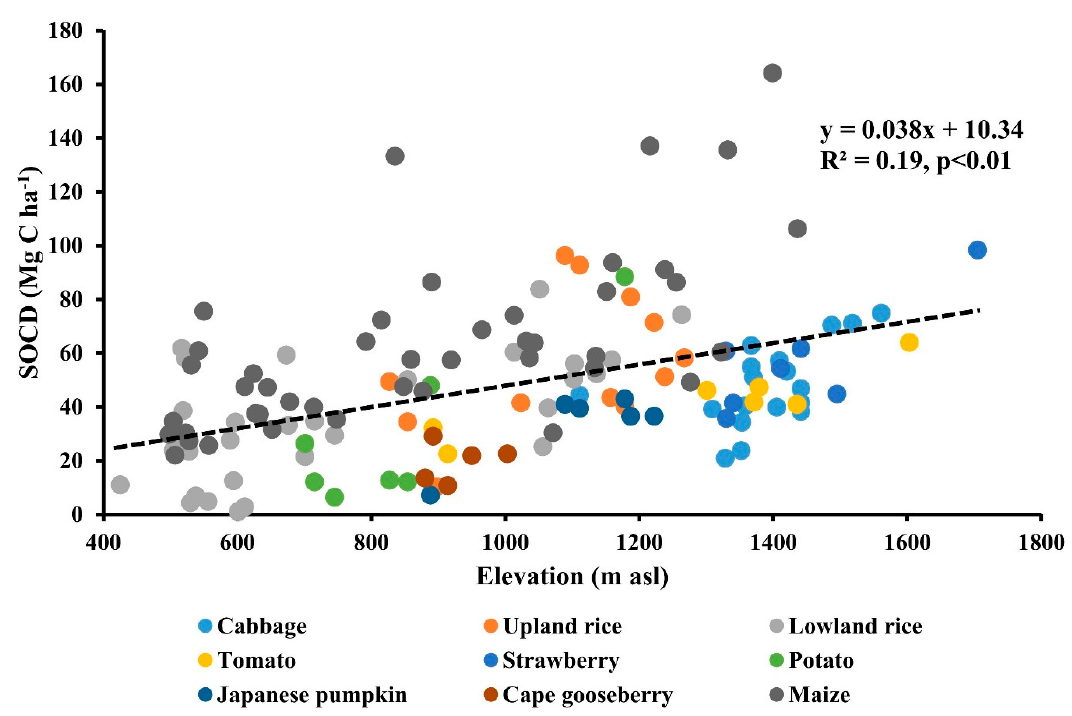
Figure 3. Relationship between SOCD and elevation at all sites.